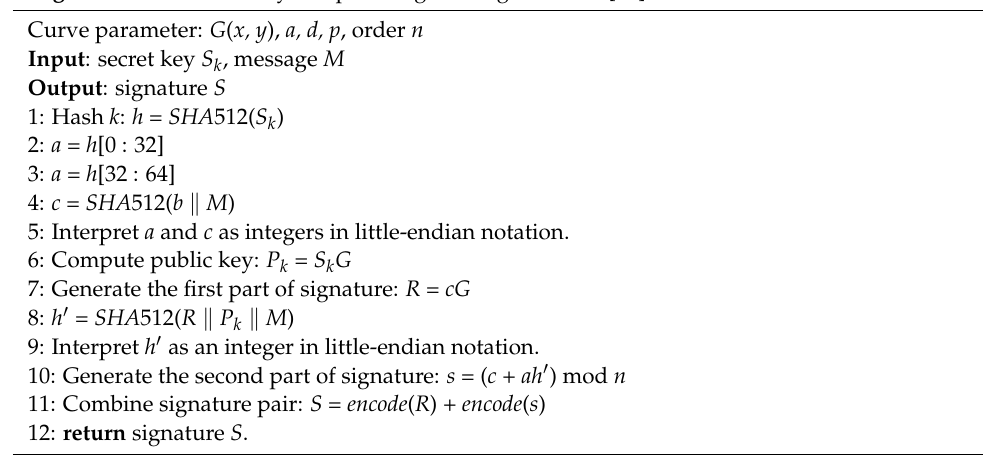
Algorithm 1. Ed25519 key setup and signature generation